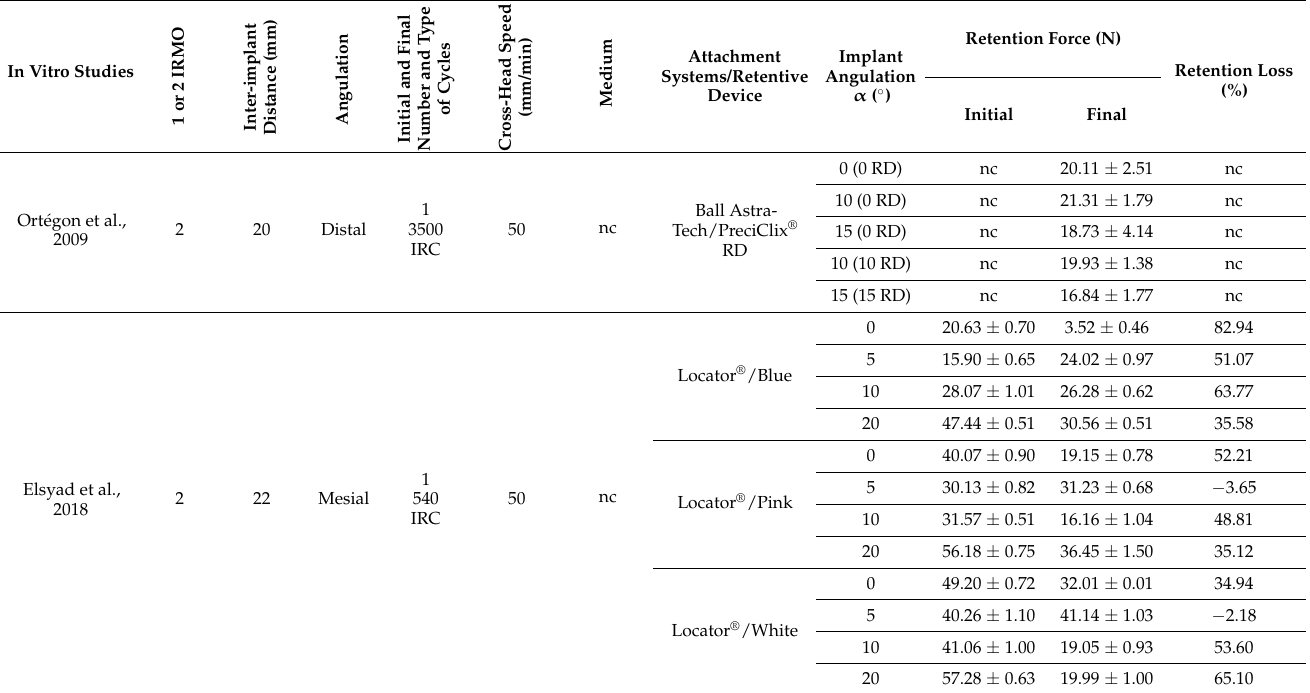
Figure 5. Overdenture with two parallel attachments on ( A ) two parallel implants, and ( B ) two non-parallel implants. Green axis: axis of insertion–removal of the denture. Black axis: axis of the implant. α : implant angulation. β : inter-implant angulation. Table 4. Influence of implant angulation on the initial retention force and after insertion–removal (IRC) and/or chewing cycles (CC) of selected ball and cylindrical attachment systems. Negative retention loss corresponds to a gain in